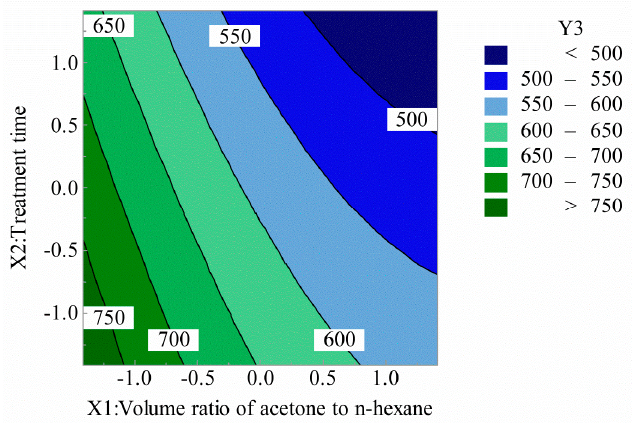
Figure 7. Volume ratio of acetone to n-hexane and treatment time for rigidity (2D).